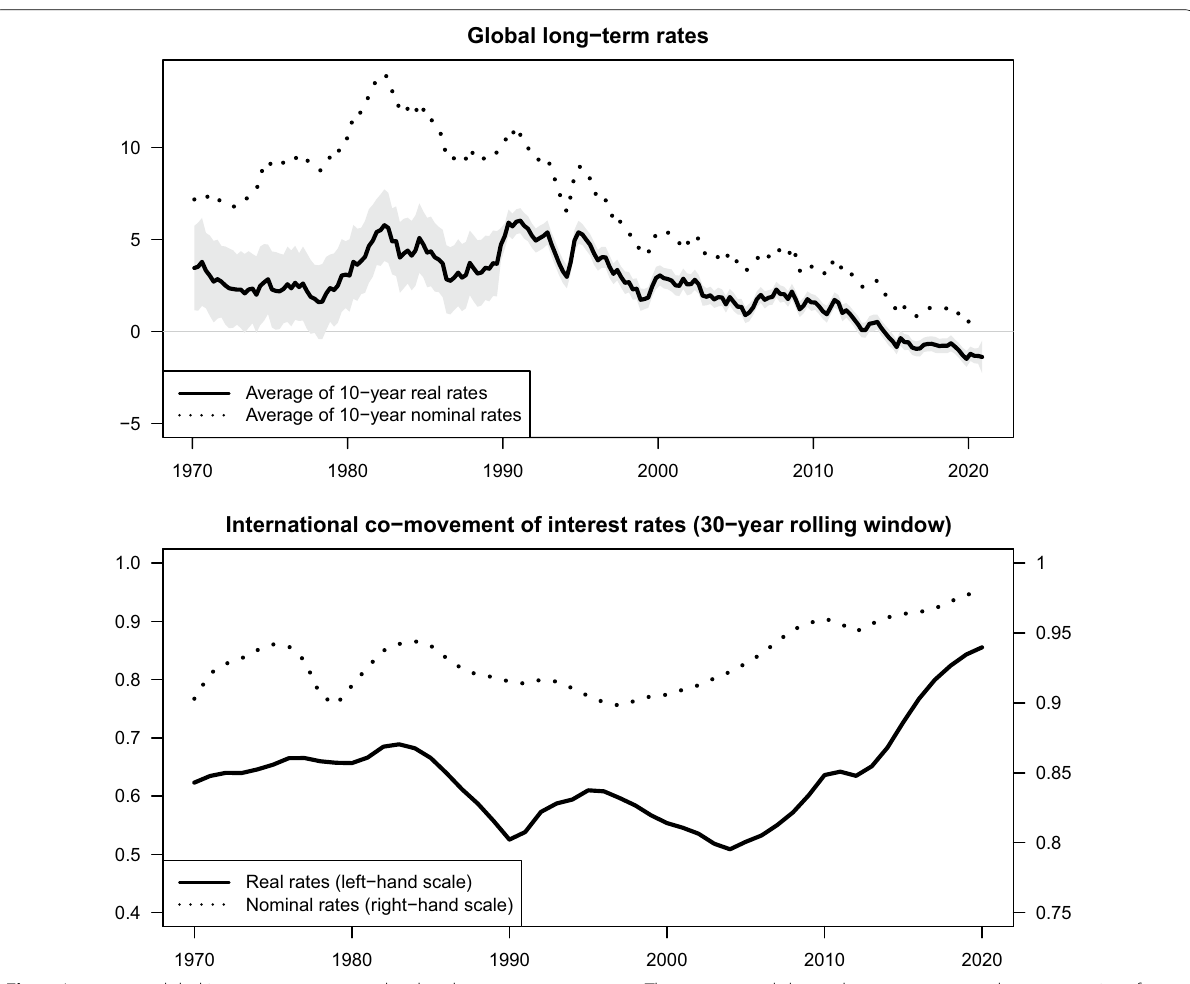
Fig. 1 Long‑term global interest rates, average level and convergence measure. The upper panel shows the average, across the 17 countries of the JST database, of the 10‑year nominal and real interest rates (in percentage points). The real rate is surrounded by a 95% confidence interval reflecting the uncertainty associated with the inflation‑expectation filtering procedure (see Appendix A.2). This confidence interval is substantially reduced in the 80s, as survey‑based forecasts then become available for several countries, which improves the quality of inflation expectations’ estimates. The lower panel illustrates the convergence of international interest rates. It displays the (time‑varying) share of variances accounted for by the first principal component of the 17 interest rates, for both real and nominal interest rates. The principal component analysis is conducted over a 30‑year rolling window. For instance, for 2020, it shows the share of the variances of the 17 (real or nominal) interest rates accounted for